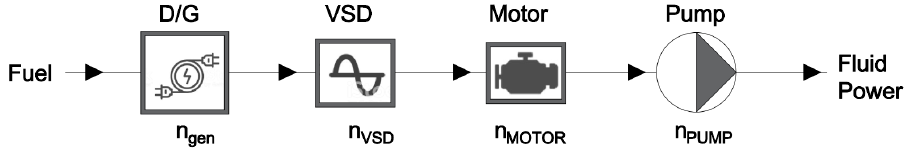
Figure 9. Schematic presentation of the power conversion path considered for the SW pump.